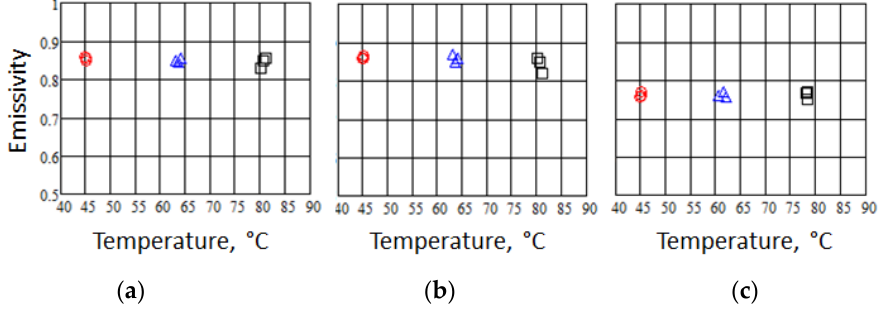
Figure 7. Large scale emissivity measurements vs. temperature of acrylic fabric samples: ( a ) acrylic coated with SiO 2 nanoparticles; ( b ) acrylic coated with TiO 2 nanoparticles; and ( c ) acrylic uncoated. The emissivity is averaged over 1cm 2 area and is measured three times for each temperature. The textiles were heated at the temperature: (o) 45 ◦ C; ( ∆ ) 60 ◦ C; and ( (cid:3) ) 80 ◦